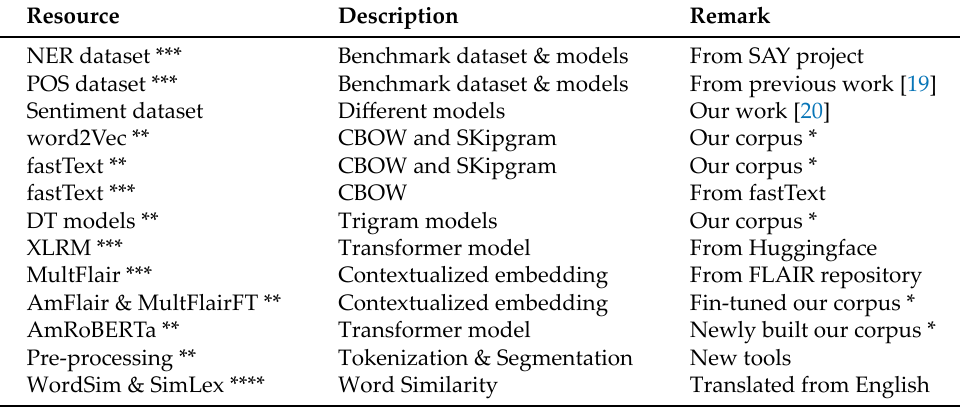
Table 1. Resources (models, preprocessing tools, and models). For existing resources, we have indicated our contributions. * indicated corpus we have gathered from the web using the Scrapy (https://scrapy.org/ (accessed on 24 October 2021)) open source and collaborative Python framework and using the Tweeter API (https://developer.twitter.com/en/docs/ (accessed on 24 October 2021)). ** indicates the models that we have built using the datasets. *** indicates semantic models that are publicly